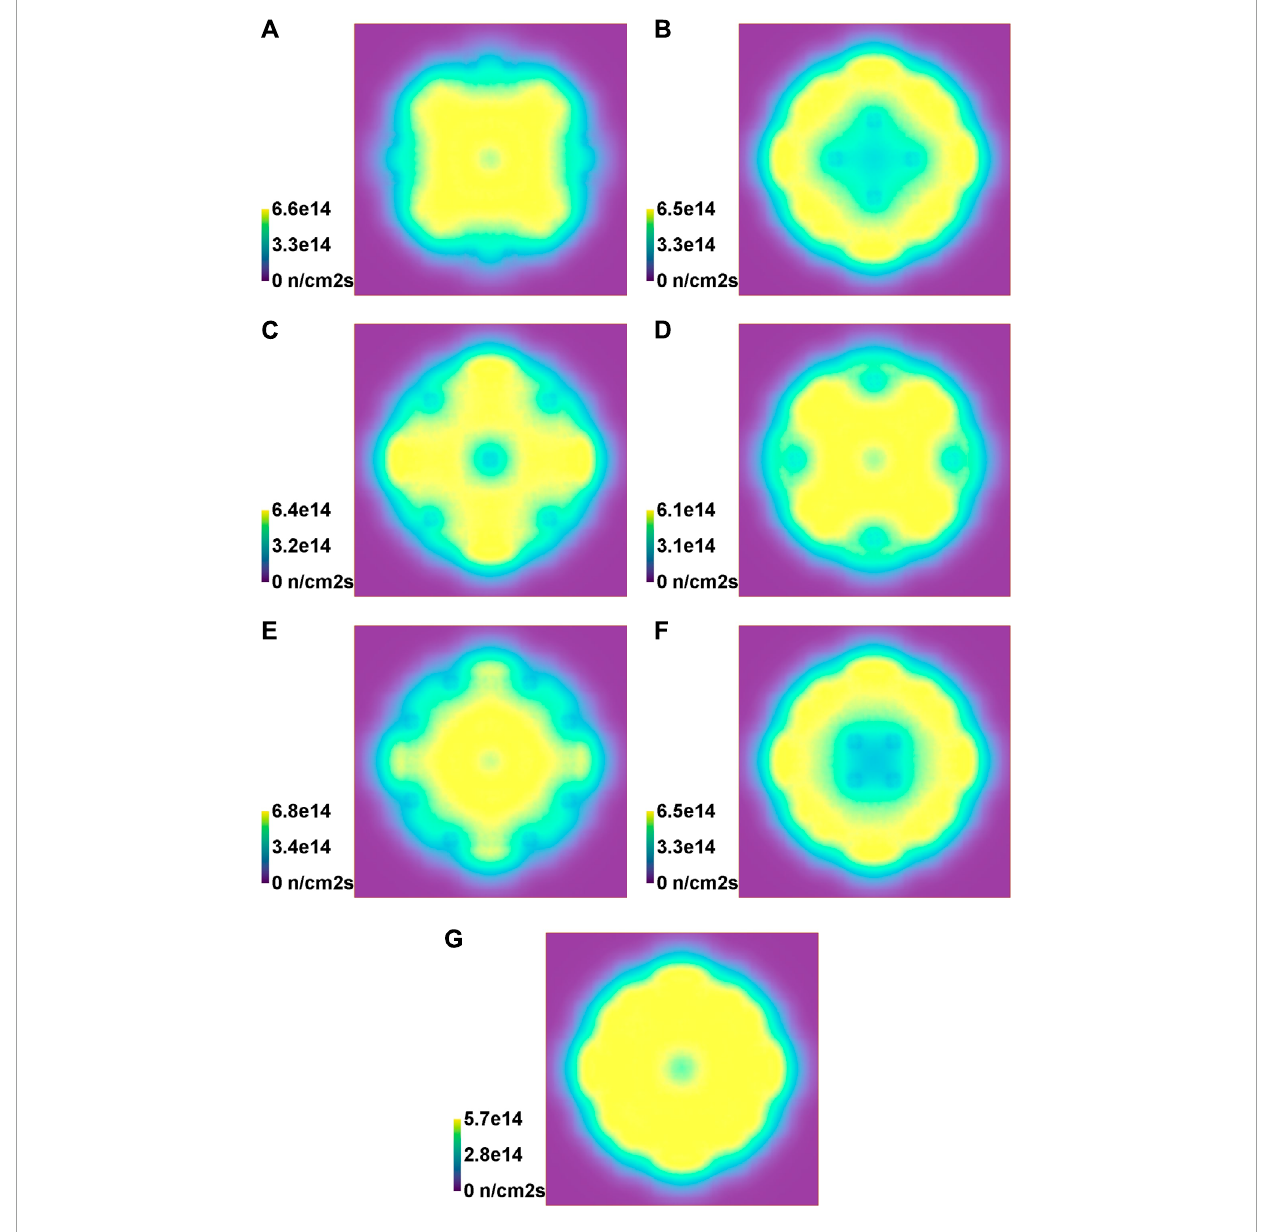
FIGURE 9 Neutron flux distribution in xy plane approximately in the middle of active core height, normalized to the maximum reactor power of 2 GW for cycle 28 HZP configuration calculated using MCNP core model for individual control rod completely inserted. Normalized neutron flux values are represented with colors, ranging from low values in blue to high values in yellow. (A) A bank. (B) B bank. (C) C bank. (D) D bank. (E) SA bank. (F) SB bank. (G) All rods out (ARO).